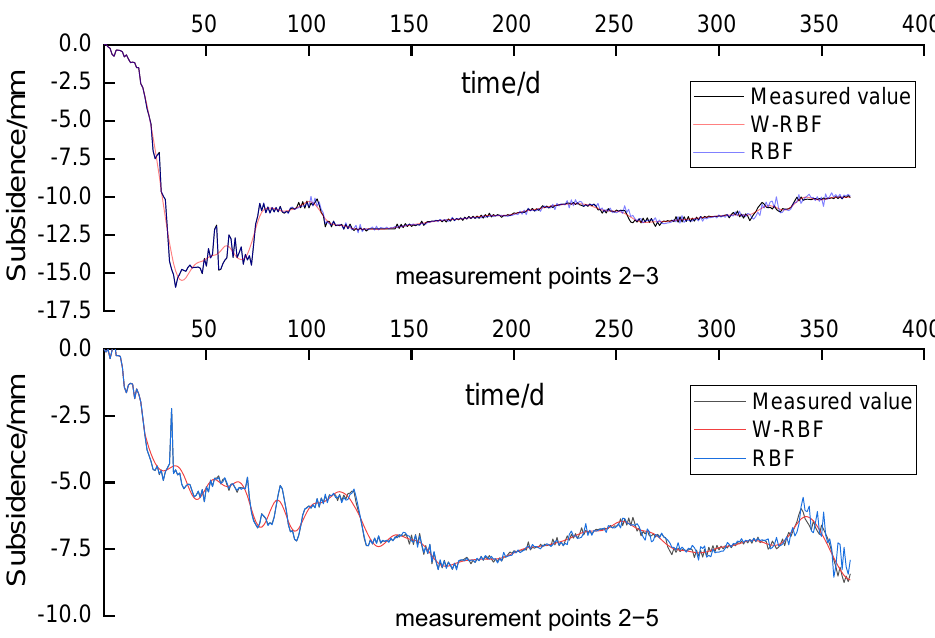
Figure 7. Comparison of the measured value of surface settlement at measurement points 2 − 3 and 2 − 5 with the predicted value.